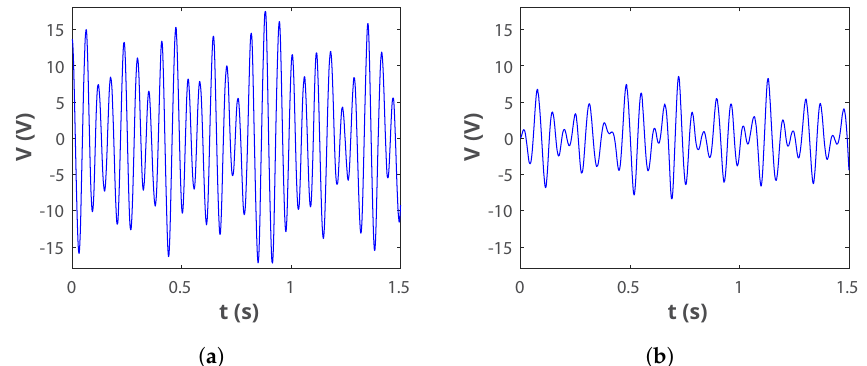
Figure 6. Output voltage delivered by the harvester: ( a ) Open circuit configuration; ( b ) Measured across R L = 12,050 Ω .